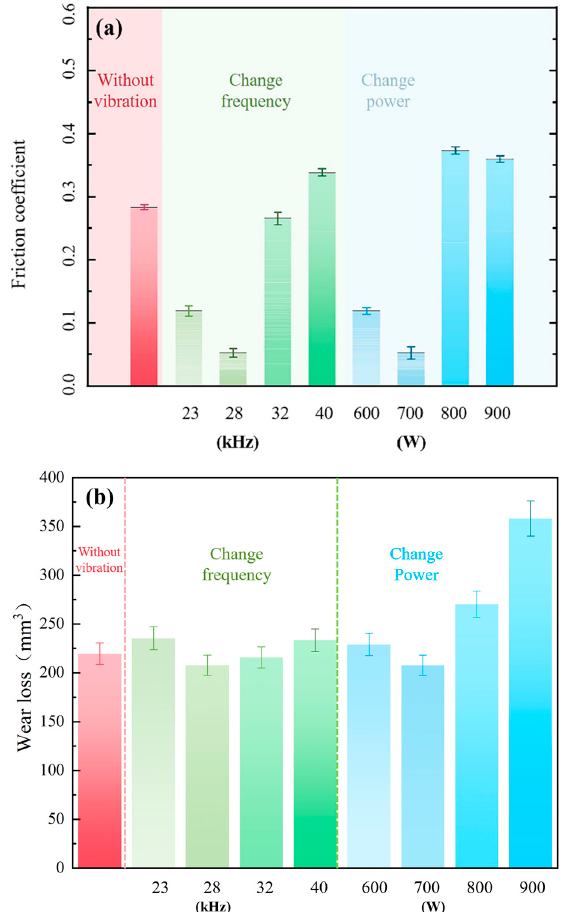
Figure 17. Effects of ultrasonic vibrations on the friction properties of coatings: ( a ) COF and ( b ) wear loss.